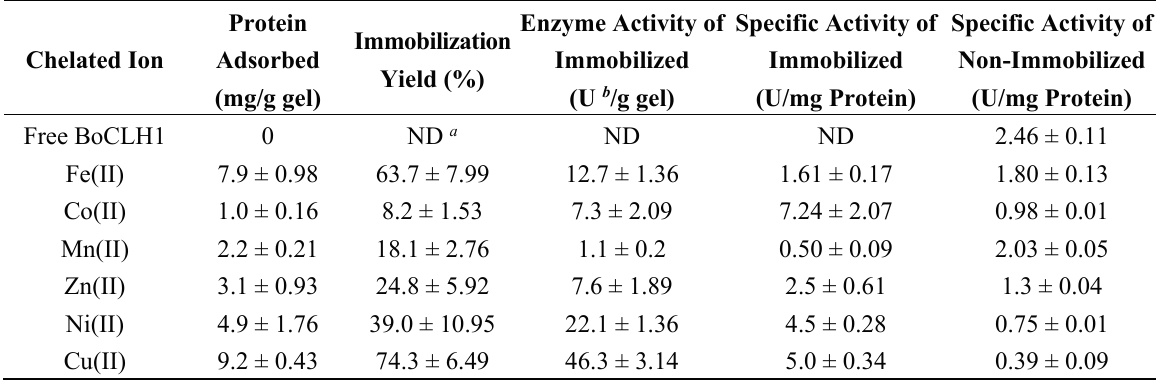
Table 1. Characterization of the immobilized BoCLH1 mediated by chelated metal ions. Protein Enzyme Activity of Specific Activity of Specific Activity of Immobilization Chelated Ion Adsorbed Immobilized Immobilized Non-Immobilized Yield (%) (mg/g gel) (U b /g gel) (U/mg Protein) (U/mg Protein) Free BoCLH1 0 ND a ND ND 2.46 ±